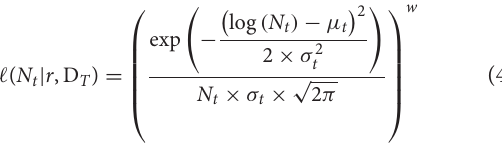
abundance estimate, is given by Equation